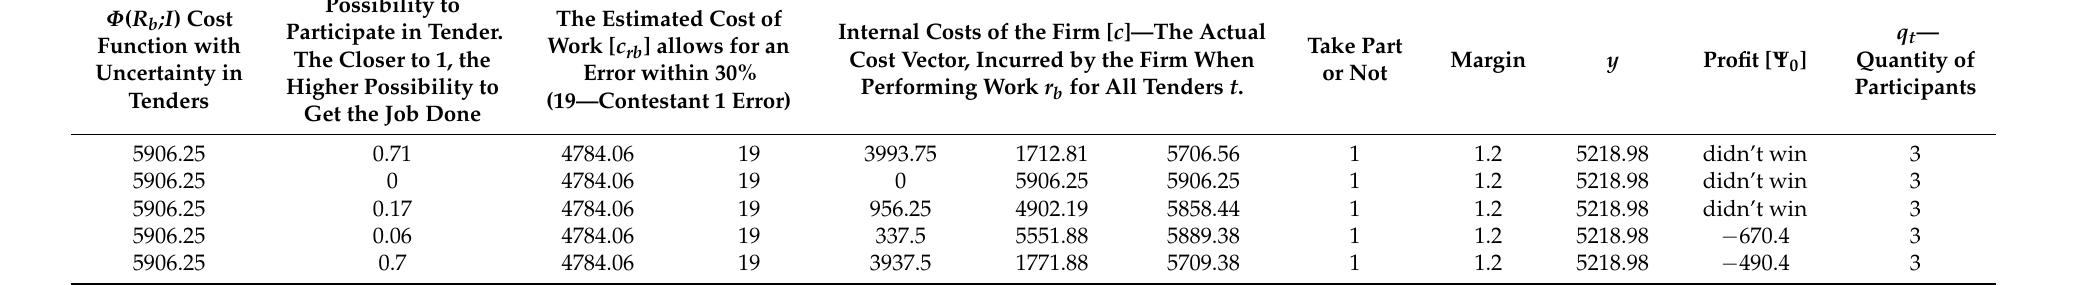
Table 4. Fragment of the spreadsheet list “Contestant 1 Behavior Model”.